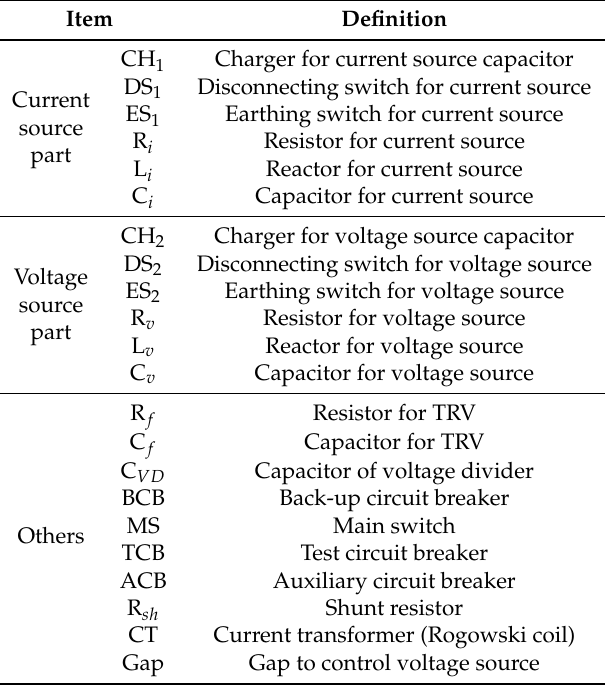
Table 2. Definition of circuit components.